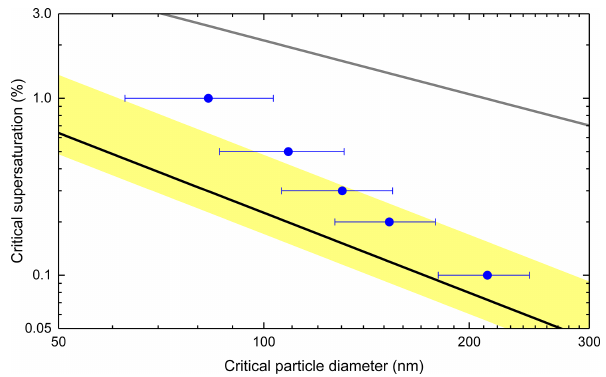
Figure 3. Critical supersaturation and effective critical dry particle diameter data pairs (blue dots) and SDs (blue error bars) determined experimentally in central Budapest, and the dependency calculated for the simulated global continental mean κ and SD of 0 . 27 ± 0 . 21 (the black line represents the mean κ value and the yellow band rep- resents ± 1SD). The relationship for insoluble but wettable particles ( κ = 0, the Kelvin term) is also shown (grey line) for comparison.